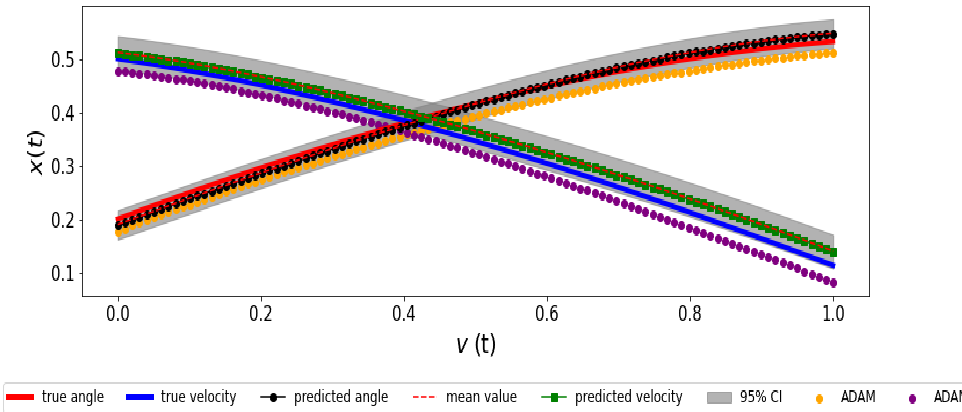
Figure 6. Inverse pendulum problem with data noise: The figure shows the comparing of the result from PINN trained by NSGA-PINN method and ADAM method with noisy input